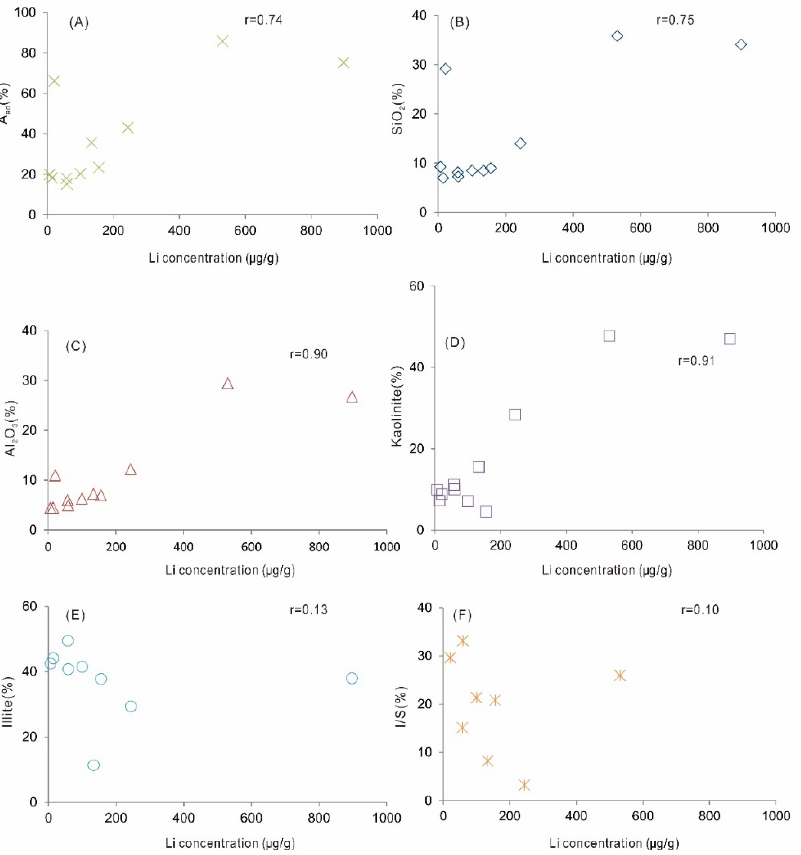
Figure 6. Relations between lithium and ash yield (A ad ) ( A ), SiO 2 ( B ), Al 2 O 3 ( C ), kaolinite ( D ), illite ( E ), and I/S ( F ) of the Donggou coals. A ad , ash on air dry basis. r, correlation coefficient.